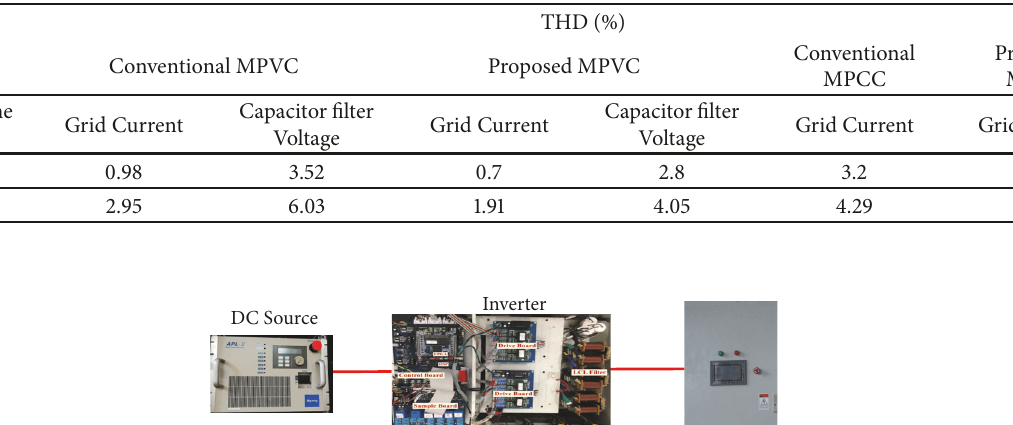
Table 2: Comparison of THD for MPVC and MPCC methods.